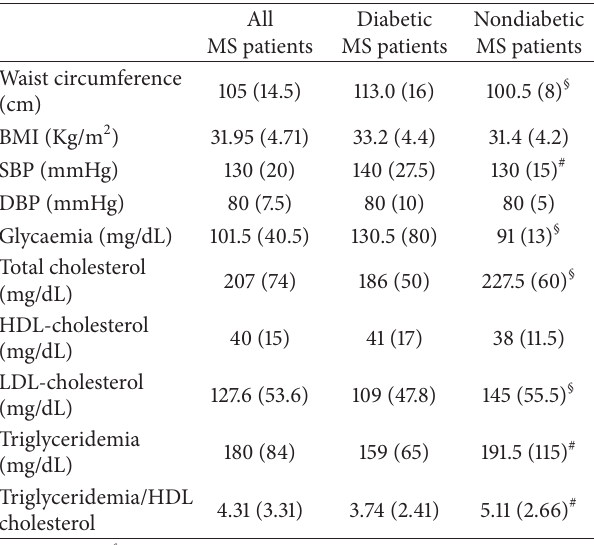
Table 1: Medians (interquartile ranges) of the anthropometric profile, blood pressure values, and metabolic pattern in the whole group of MS subjects and in the two subgroups of MS subjects, respectively, with and without diabetes